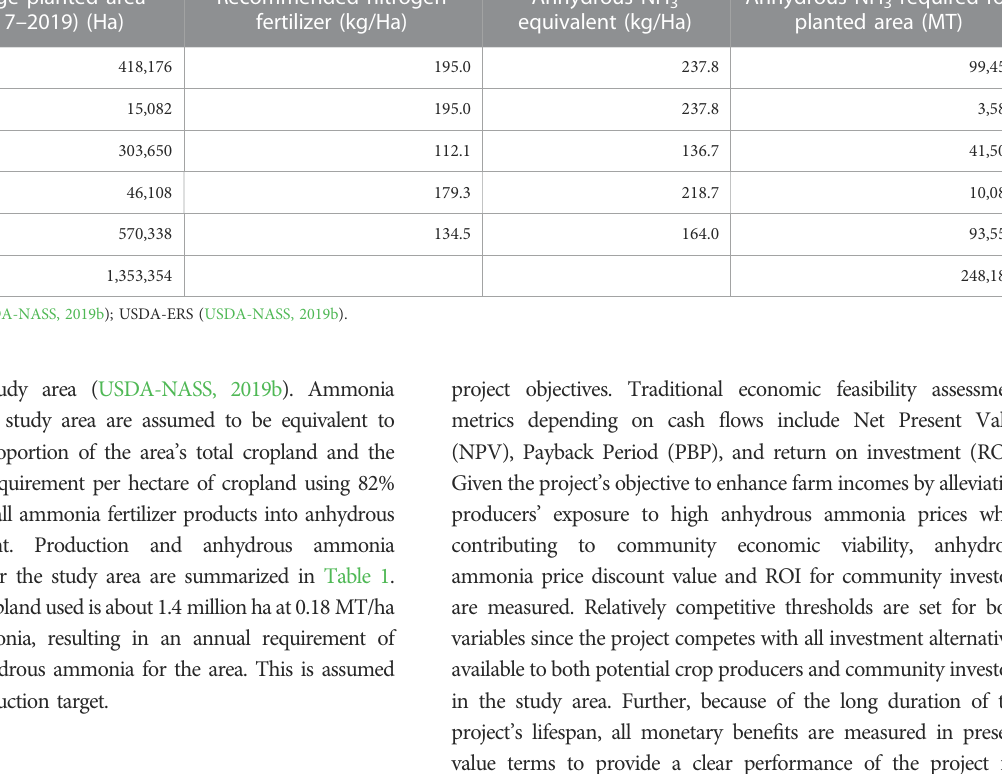
TABLE 1 Cropland and fertilizer assumptions.